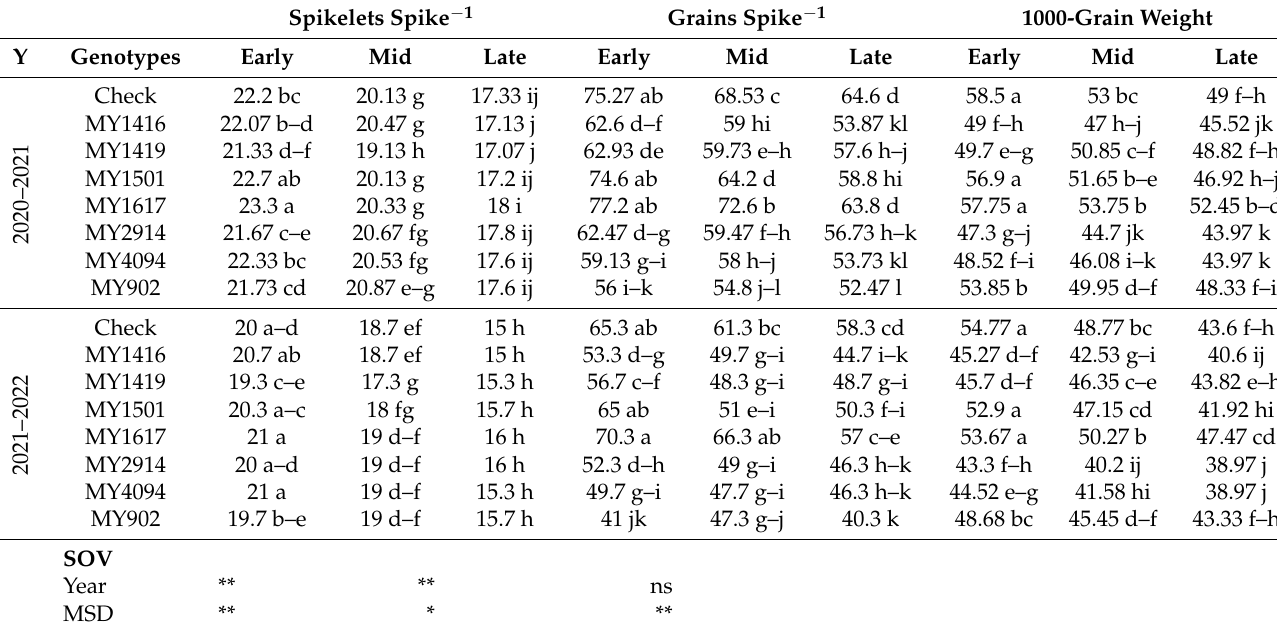
Table 6. Spikelets spike − 1 , grains spike − 1 , and thousand grain weight (g) of different wheat genotypes grown under the semi-arid climate of northern